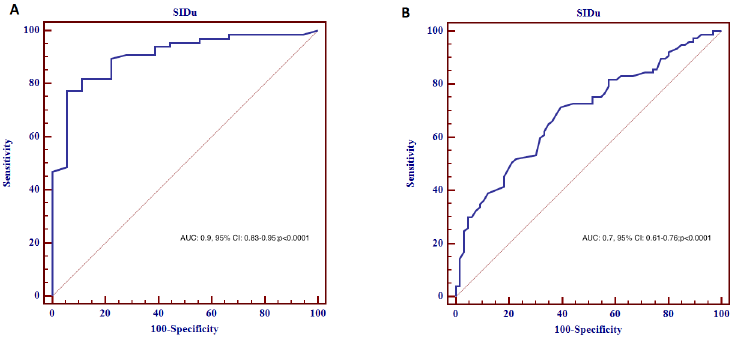
Fig 2. A . Receiver Operating Characteristic curve for day-0 urinary Strong Ion Difference(SIDu) to discriminate controls (no-AKI) and P-AKI patients. B . Receiver Operating Characteristic curve for day-0 urinary Strong Ion Difference(SIDu) to discriminate R-AKI and P-AKI